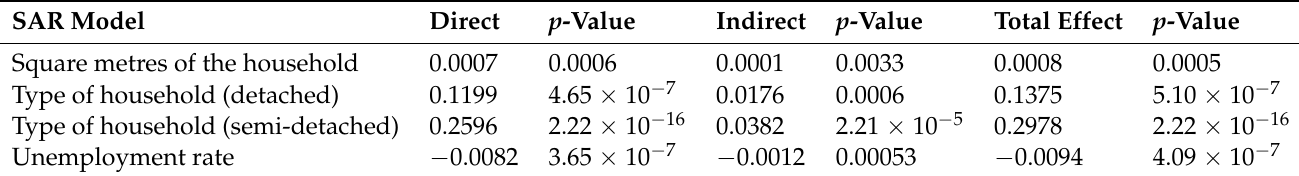
Table 2. SAR model results.